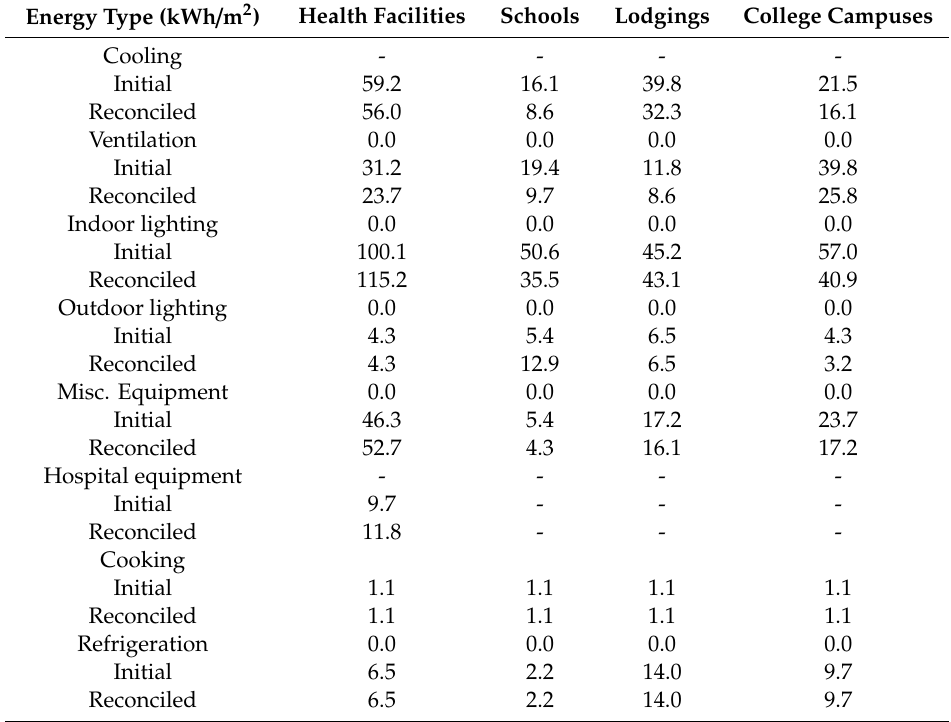
Table 7. Annual energy intensity in kWh / m 2 for the four commercial buildings in